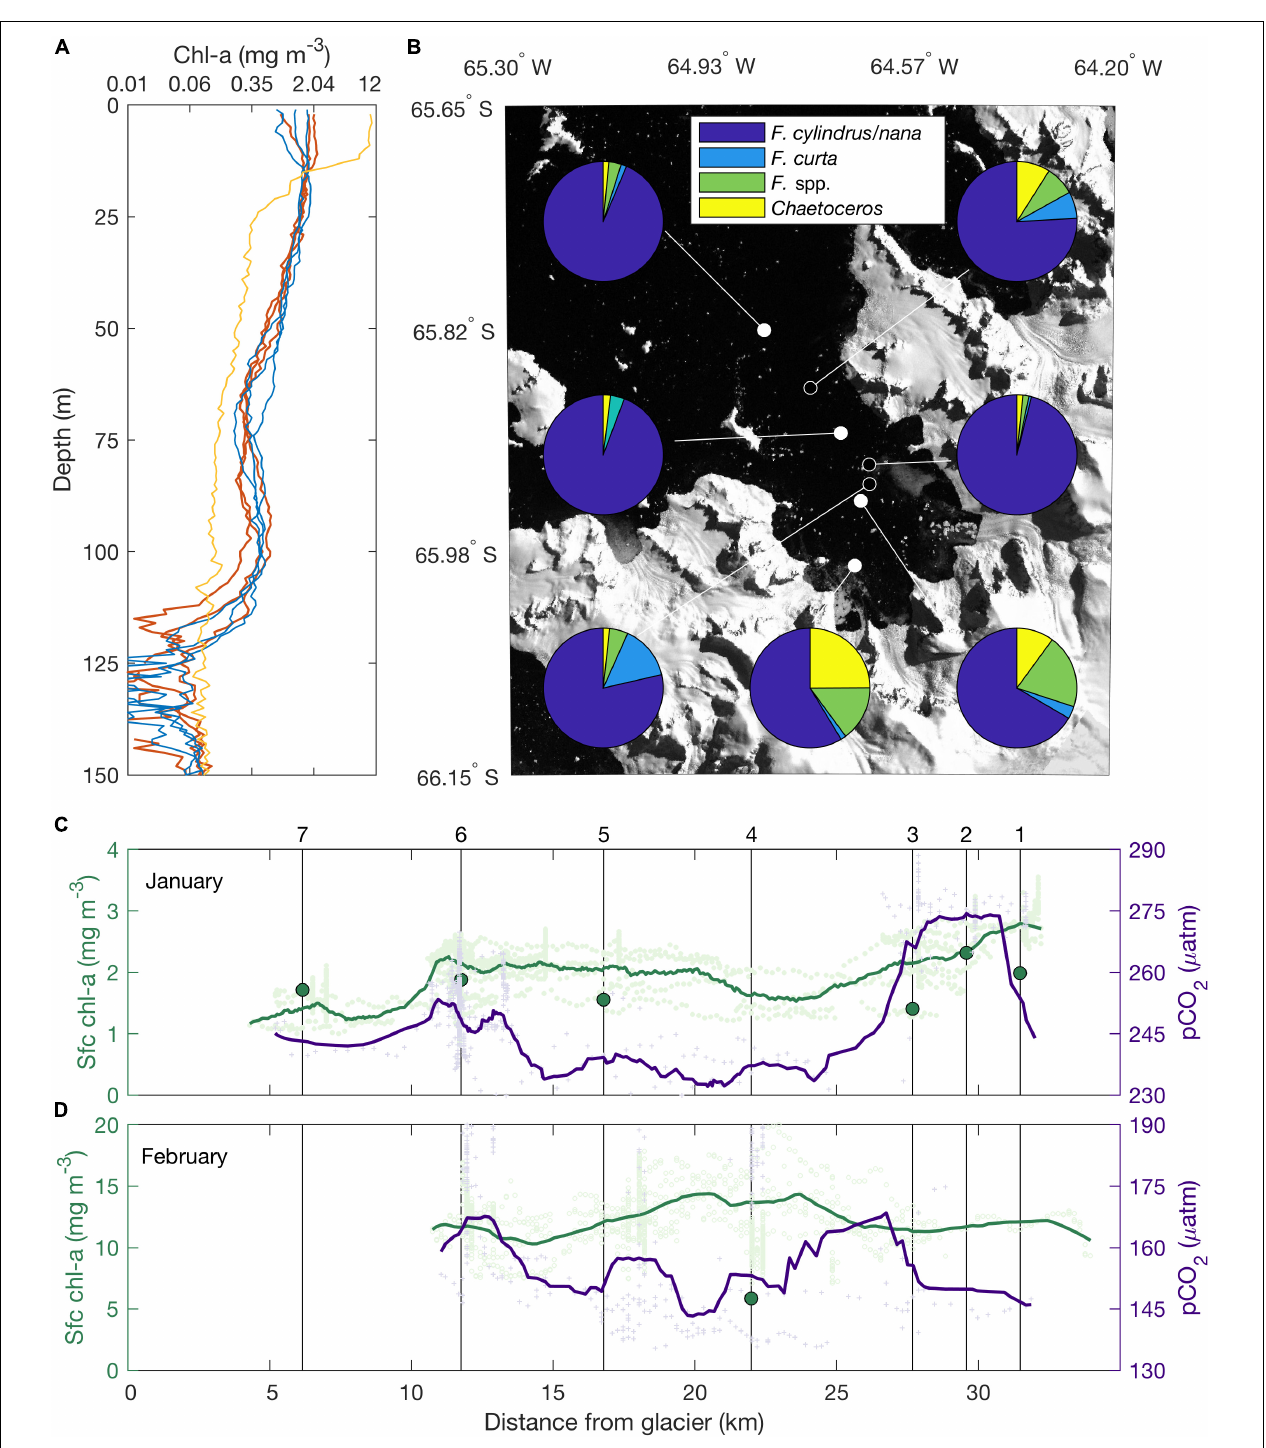
FIGURE 8 | Phytoplankton biomass, community composition, and CO 2 drawdown. (A) Vertical profiles of in vivo chl-a biomass. Note the log scale. (B) Diatom community composition of surface waters sampled from the ship’s flow-through system. Stations sampled in January and February are indicated by filled and hollow white points, respectively. Along-track, surface chl-a and pCO 2 measured in (C) January and (D) February along the section shown in Figure 1A . Note changes in scales. Dark green points indicate discrete extracted chl-a samples collected from the ship’s flow through. Light green and purple points correspond to discrete measurements of in vivo chl-a and pCO 2 , respectively, with low-pass filtered data indicated by colored lines. Station locations are noted by black vertical line.